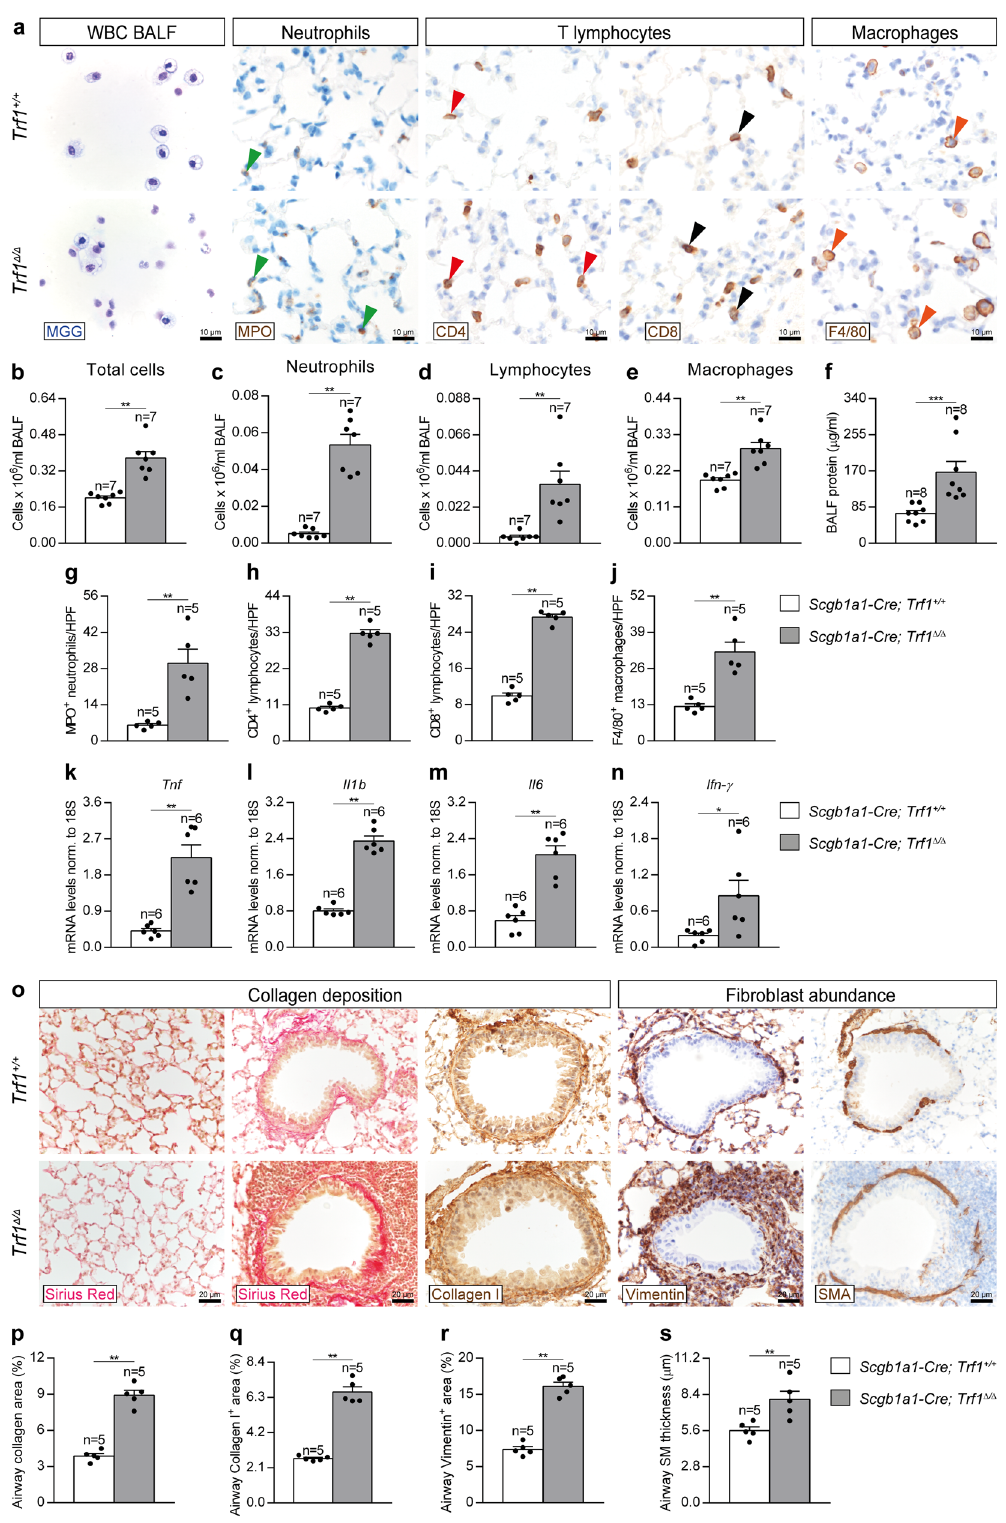
Fig. 7 | Trf1 deletion in club cells increases lung in fl ammation and airway remodeling. a Representative BALF cytospin preparations (May-Grünwald Giemsa (MGG))andimmunostainingsforMPO(neutrophils),CD4andCD8(Tlymphocytes) and F4/80 (macrophages) in lung sections from Trf1 +/+ and Trf1 Δ / Δ mice. Quanti fi ca- tionoftotal( b )anddifferentialBALFcellcountsforneutrophils( c ),lymphocytes( d ) andmacrophages( e ),andtotalproteinconcentrationinBALF( f )of Trf1 +/+ and Trf1 Δ / Δ mice.Quanti fi cationoflungMPO( g ),CD4( h ),CD8( i )andF4/80( j )positivecellsper 40X high-power fi eld (HPF), and lung tissue mRNA expression levels of Tnf ( k ), Il1b